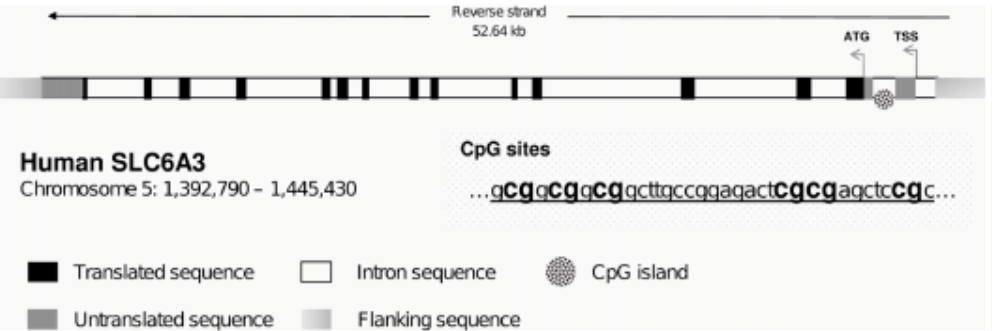
Figure 1. The human SLC6A3 gene or DAT1 is represented. The abbreviations TSS and ATG represent the transcription start site and the translation start site, respectively. CpG island is located in the 5′ -UTR of the gene and contains the five CpG sites (in bold) we studied. The underlined region is reported from +712 to +746 relative to TSS; the first “cytosine-P-guanine” is positioned at 1,444,717 (at +713) and 1,444,716 (at +714) on the reverse strand of chromosome 5.